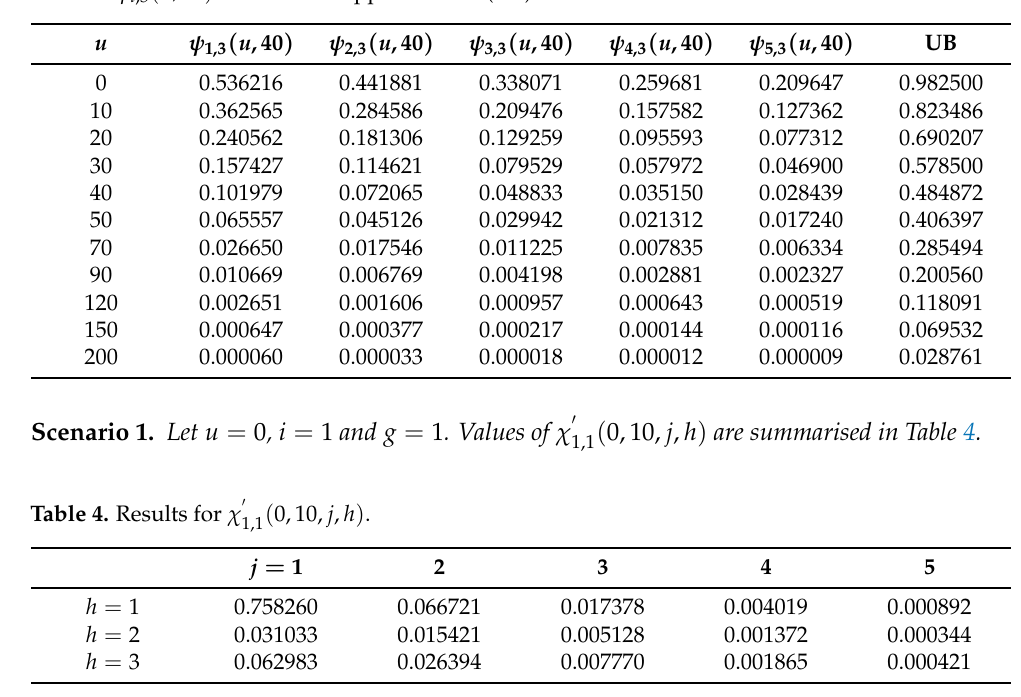
Table 3. ψ i ,3 ( u ,40 ) values with upper bounds (UB).